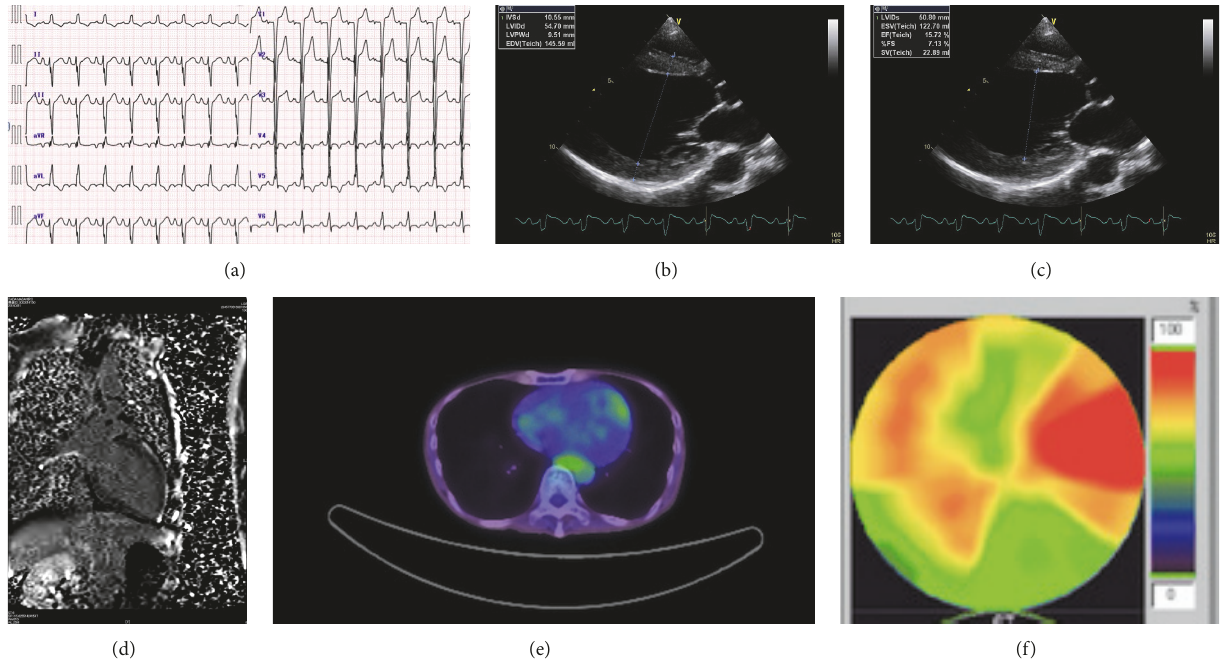
Figure 1: (a) Electrocardiogram showed left ventricular hypertrophy with ST changes. (b) Transthoracic echocardiography, long axis view, end-diastolic phase, left ventricular end-diastolic diameter = 54 mm, interventricular septal diameter = 10.6 mm, and left ventricular posterior wall diameter = 9.5 mm. (c) Transthoracic echocardiography, long axis view, end-systolic phase, and left ventricular end-systolic diameter = 48 mm. (d) Magnetic resonance imaging showed no delayed enhancement. (e) Positron emission tomography-computed tomography showed no remarkable findings. (f) Beta-methyl-p- 123 I-iodophenyl-pentadecanoic ( 123 I-BMIPP) myocardial scintigraphy showed diffuse decreased accumulation except lateral